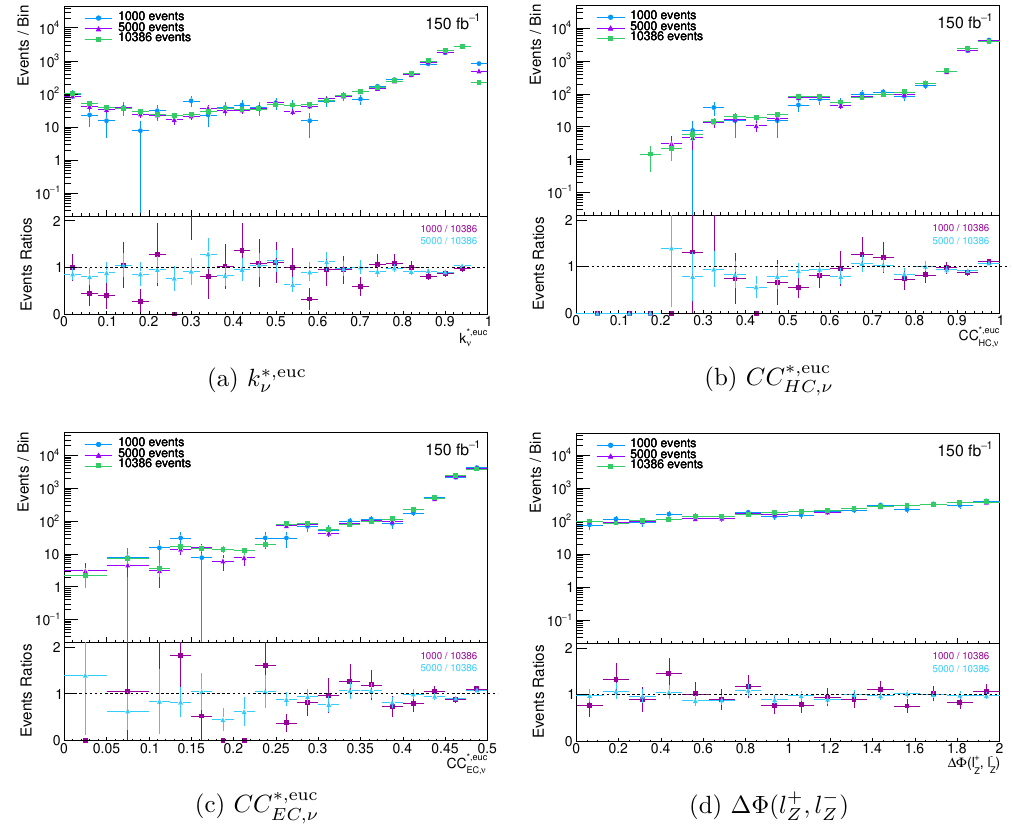
Figure 13. Event rates for the electroweakino case study as a function of the network metrics calculated using d euc , calculated using different background sample sizes. Events in the overflow bin are not shown in the